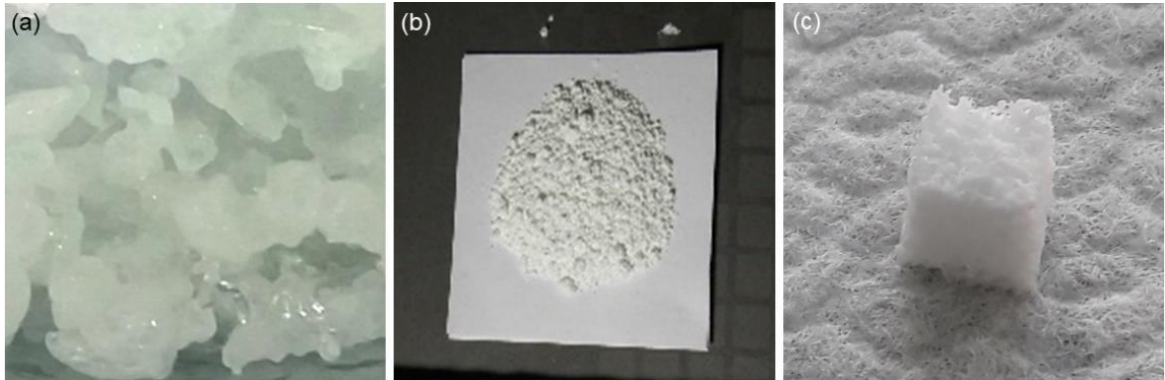
Figure 1. Visual appearance of the produced samples: ( a ) 1d glass frit, ( b ) glass powder after milling and ( c ) 1d glass-derived sintered scaffold (the size of scaffold is ~8 mm due to volumetric shrinkage taking place during